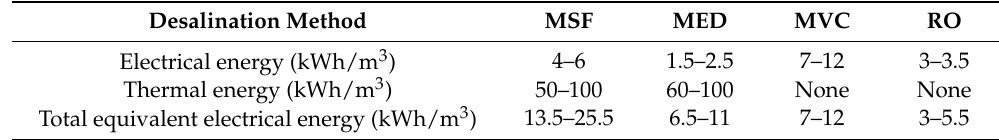
Figure 1. Distribution of water resources on the earth. Table 1. Energy consumption of various desalination methods [10–12].